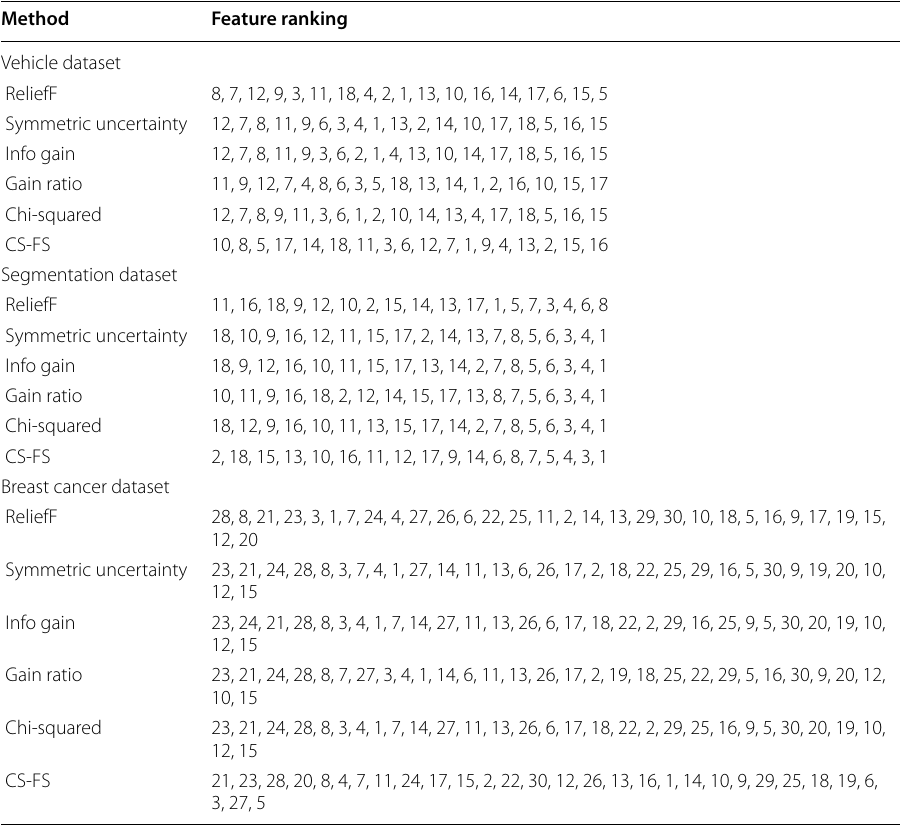
Table 4 Important features identified by various feature selection methods for classification task (ranked in the descending order of their